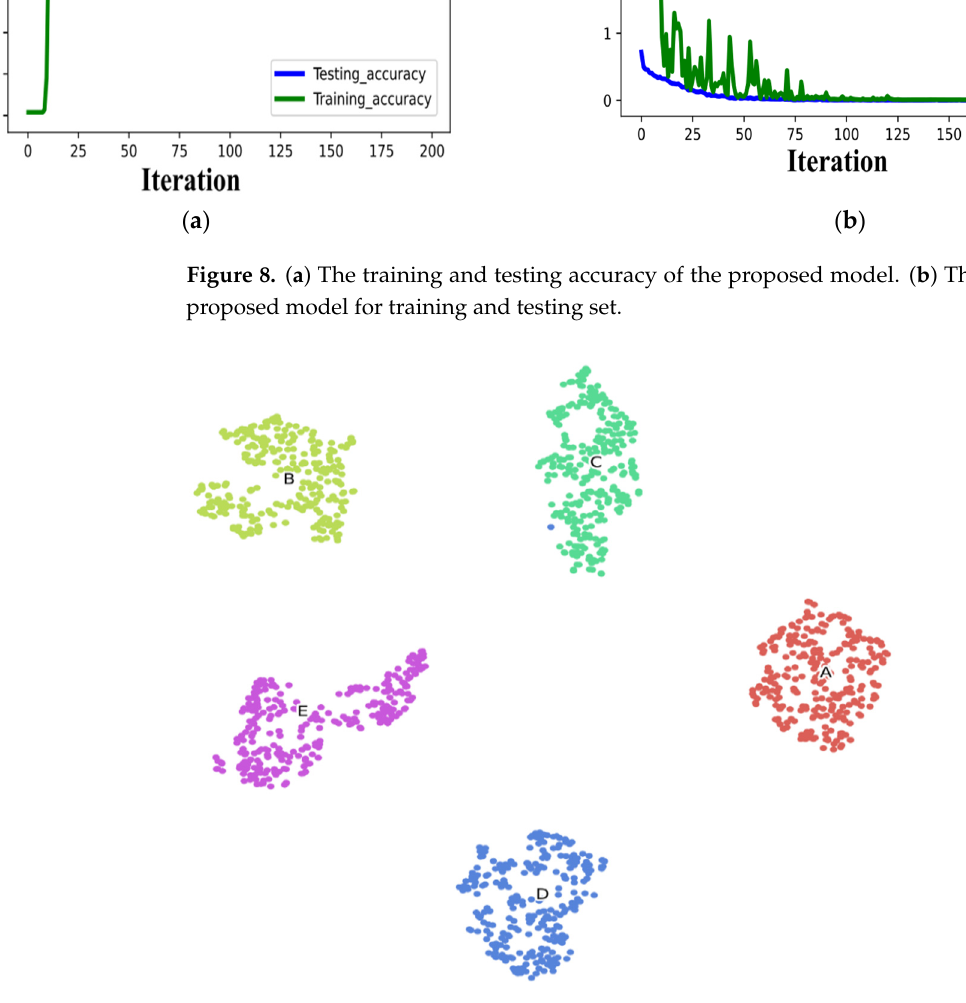
Figure 9. Two-dimensional t-SNE visualization of the learned representations of the Epileptic-Net model for the 10% data of the entire dataset.